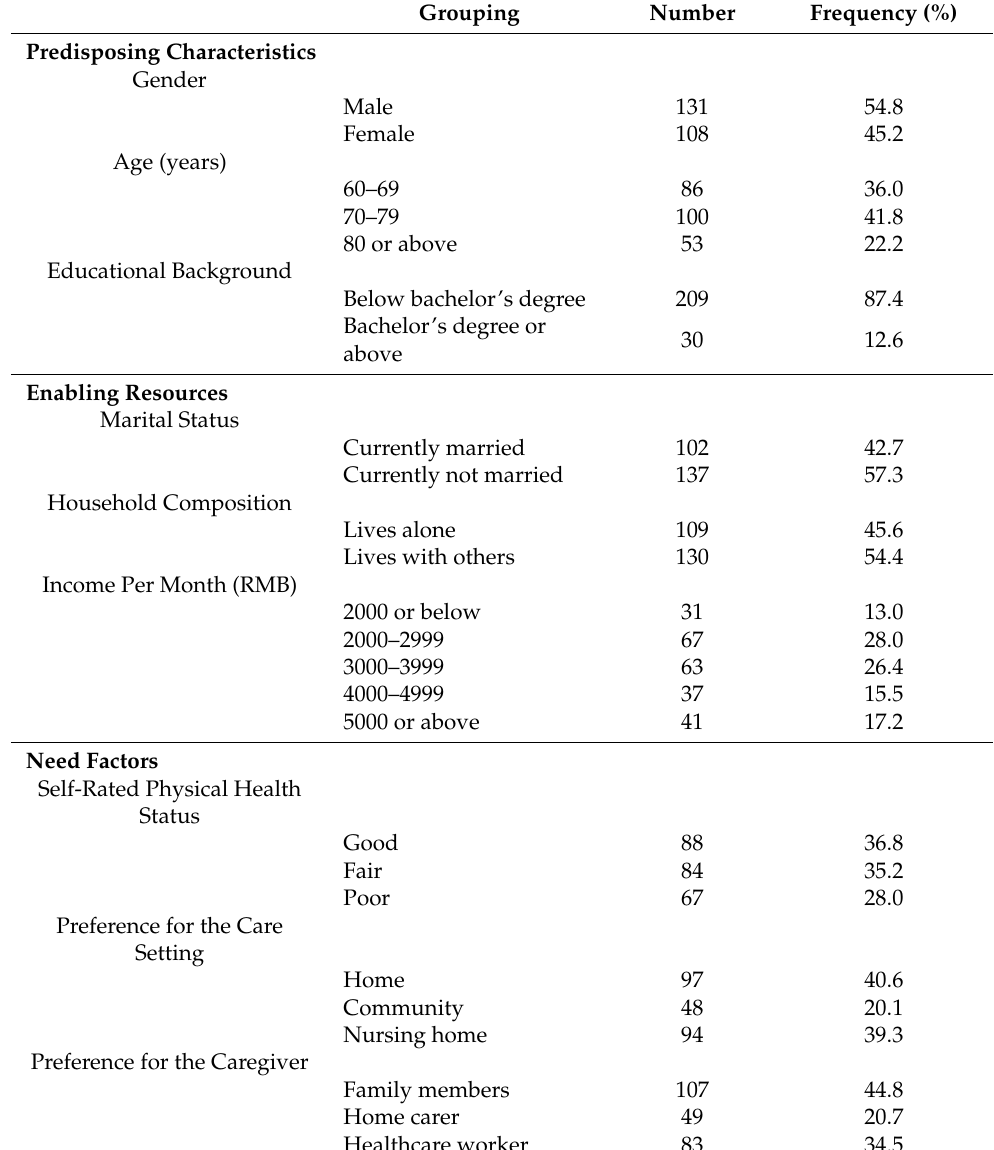
Table 1. Sociodemographic characteristics of samples ( n =